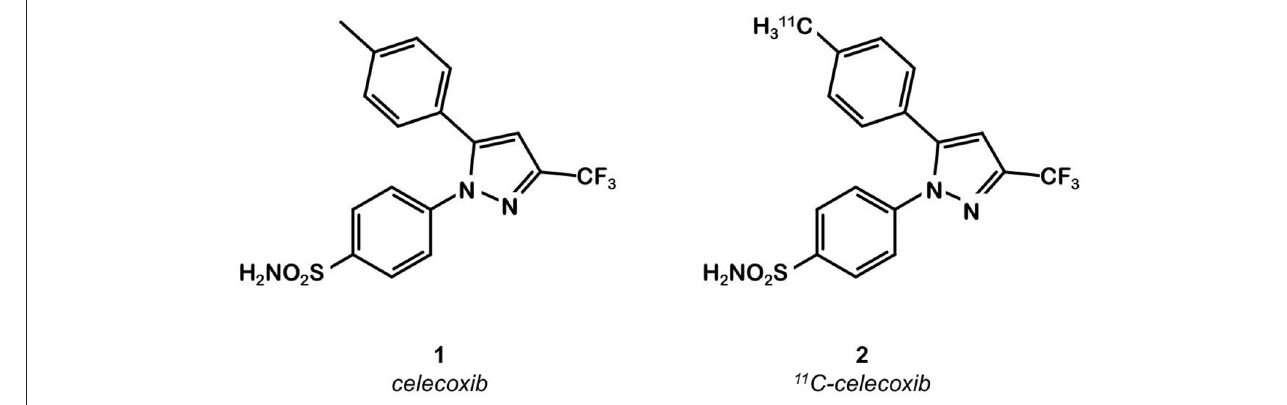
FIGURE 1 | Celecoxib and 11 C-celecoxib structures.